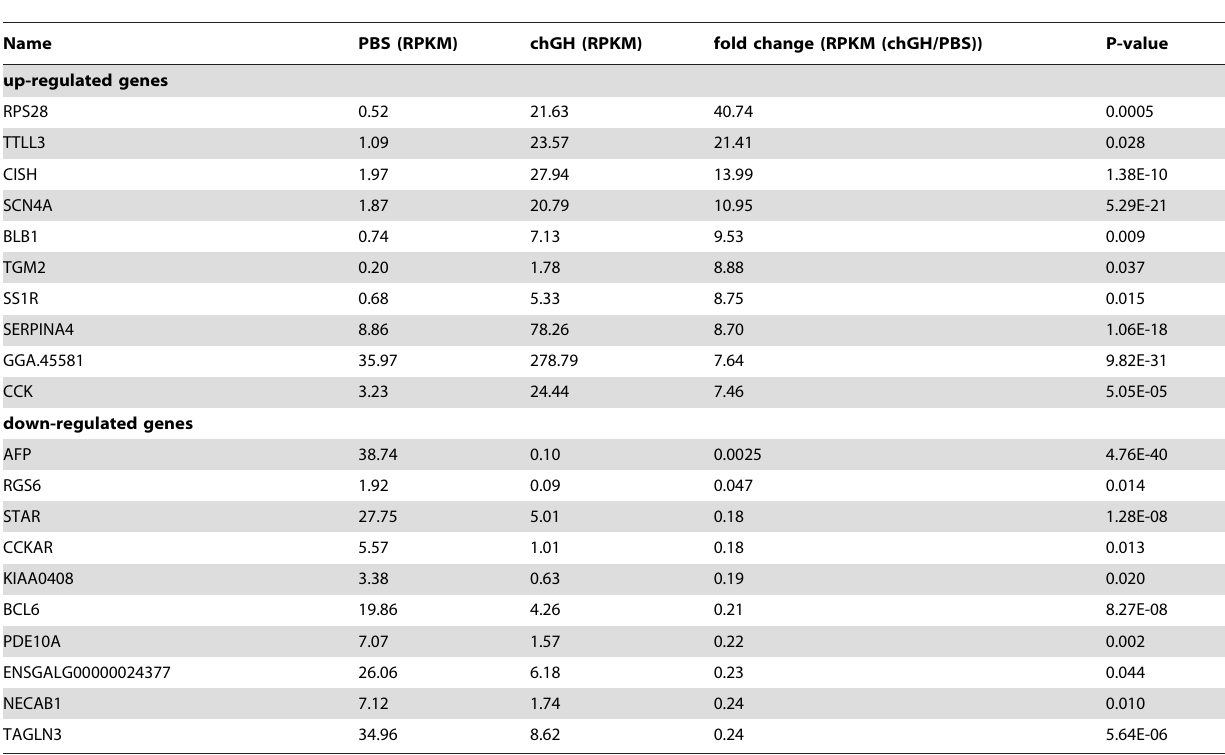
Table 2. Top 10 GH up-regulated and top 10 GH down-regulated mRNA-encoding